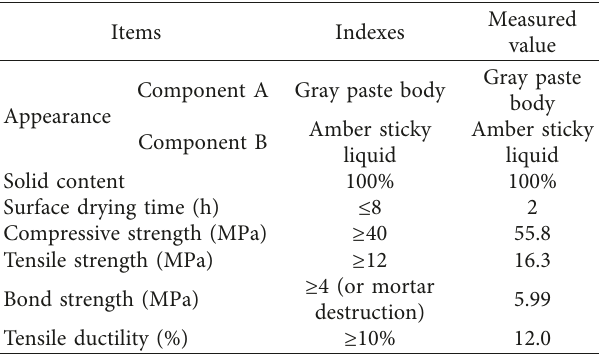
Table 5: Properties of flexible epoxy coating.